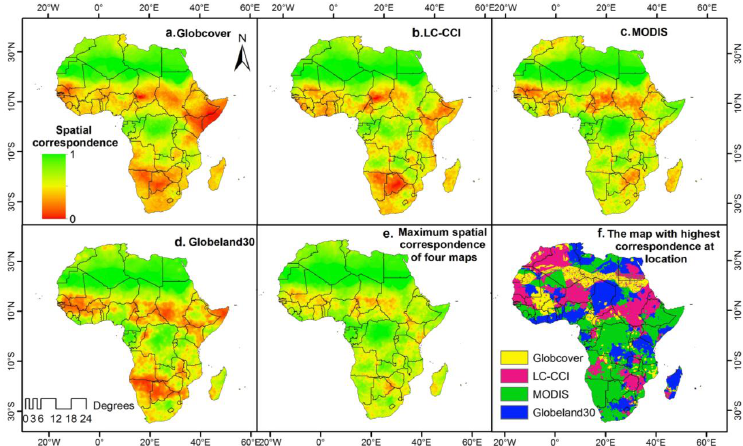
Figure 7. Spatial correspondence of the GLC maps ( a – d ), maximum correspondence ( e ) and the map with highest correspondence ( f ). with highest correspondence ( f